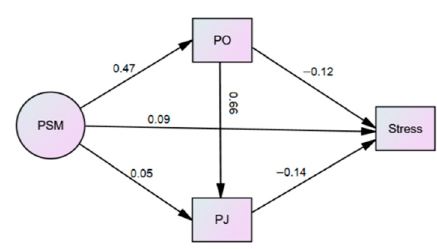
Figure 2. Study results.